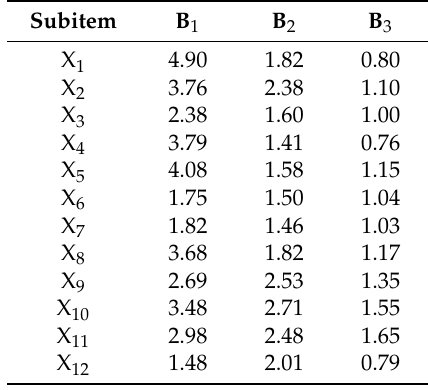
Table 3. The weighted overall scores of the 3 Level 2 indices for 12 classes of flood control materials. Subitem B 1 B 2 B